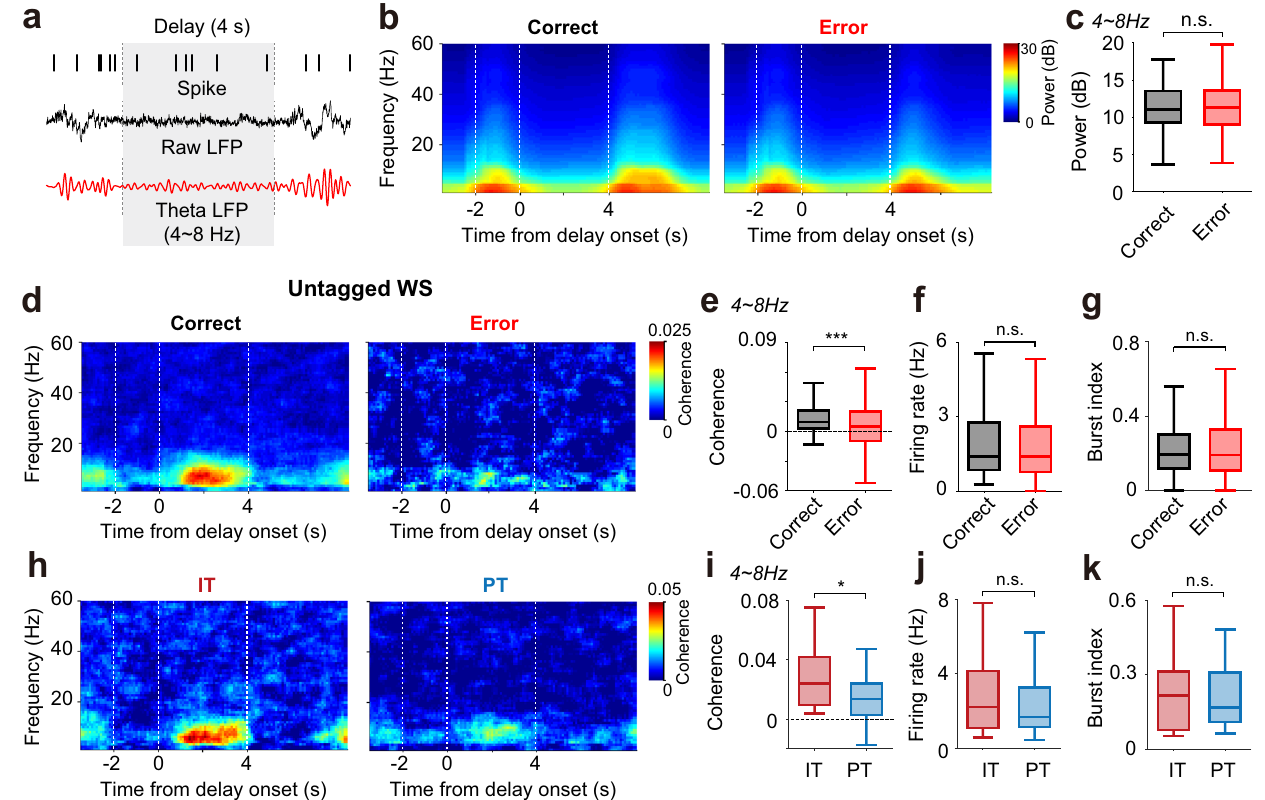
Fig. 5 Coupling of spikes to theta-frequency activity. a Example spike trains and LFP signals during the delay period. b LFP power spectrograms during correct and error trials ( n = 130 sessions with ≥ 2 error trials for both targets). c Mean theta (4 – 8 Hz) LFP power during the delay period in correct and error trials. n.s., p > 0.05 (paired t -test). d – g Spike- fi eld coherence of untagged WS neurons ( n = 352 recorded in the sessions with ≥ 2 error trials for both targets) in correct and error trials. d Frequency-dependent spike- fi eld coherence. The trial-shifted coherogram was subtracted from the raw coherogram to remove spurious covariation. e – g Mean spike- fi eld coherences in the theta (4 – 8 Hz) band, fi ring rates, and burst indices during the delay period in correct and error trials. n.s., p > 0.05, *** p < 0.001 (paired t -test). h – k Spike- fi eld coherences in the theta band, fi ring rates, and burst indices of IT ( n = 25) and PT ( n = 31) neurons in correct trials. The same format as in d – g except that only correct trials were analyzed. n.s., p > 0.05, * p < 0.05 ( t -test). Boxplots ( c , e – g and i – k ) show median, interquartile range, and maximum and minimum within 1.5 interquartile